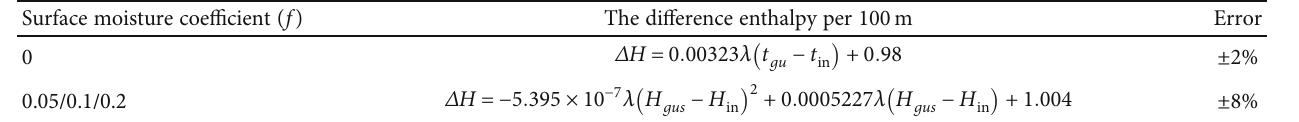
Table 2: The formula of the di ff erence enthalpy per 100m along of the intake shaft. Surface moisture coe ffi cient ( f )